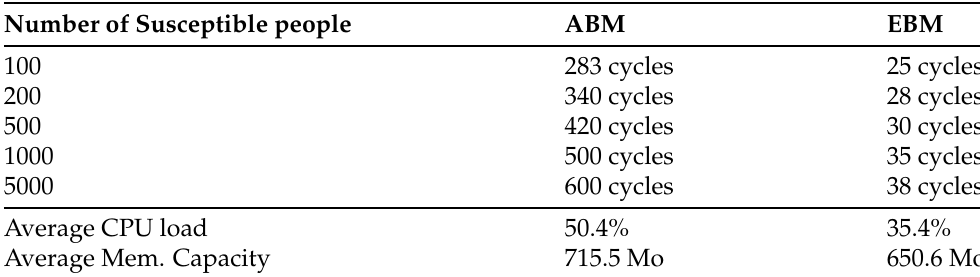
Table 5. Time cycle comparison